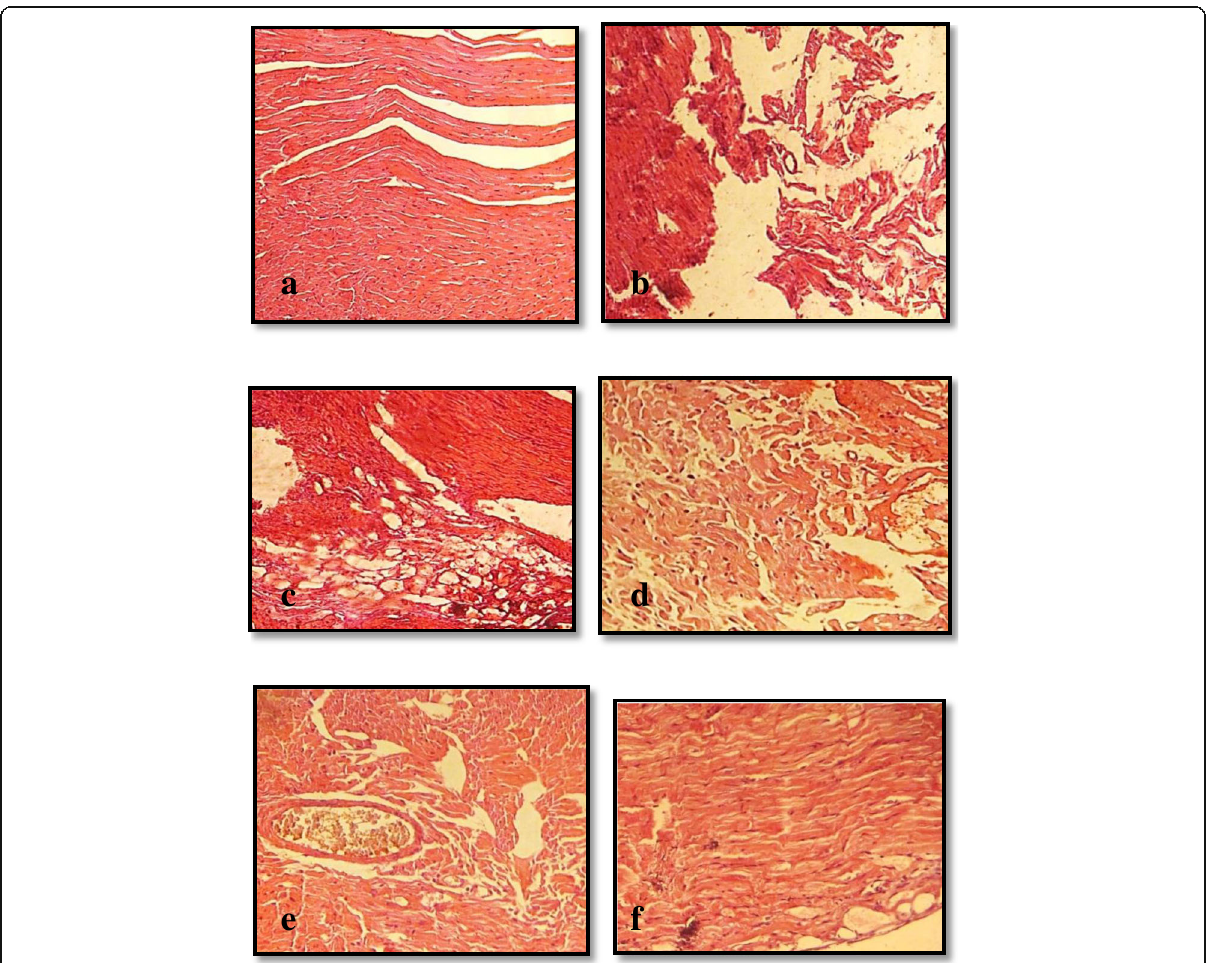
Fig. 2 Histopathology of the rat heart from different treated groups. a : control group heart showing the normal architecture of cardiac muscle. b, c, d, e, f : doxorubicin-induced group heart showing disruption of cardiac muscle architecture, vacuolation, necrosis, congestion and inflammatory cell infiltration,